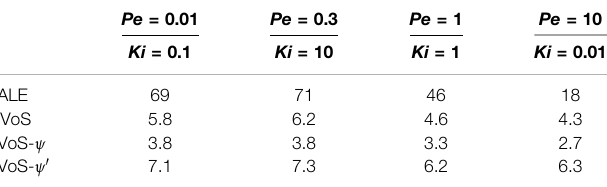
TABLE 4 | CPU time (in hours) obtained for all three methods for all four regimes during dissolution in a 2D micromodel. Pe =